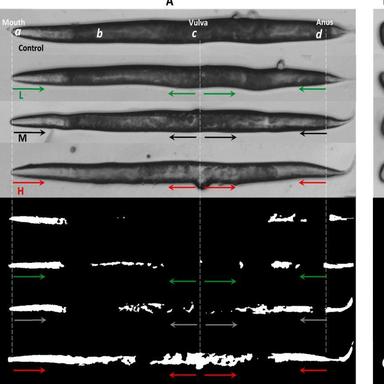
Real images of treated nematodes before shaking and eggs. A: treated nematodes before shaking. B: extracted eggs after treatment. Top: real image of treated nematodes from a multispectral slice (540 nm). Bottom: binary image after segmentation (thresholded 93–255 grey value). Vertical discontinuous lines denote anatomical orifices. L: low concentration; M: medium concentration; H: high concentration. Arrows indicate proposed direction of alkaline hypochlorite access through anatomical orifices. L; M; H. Let